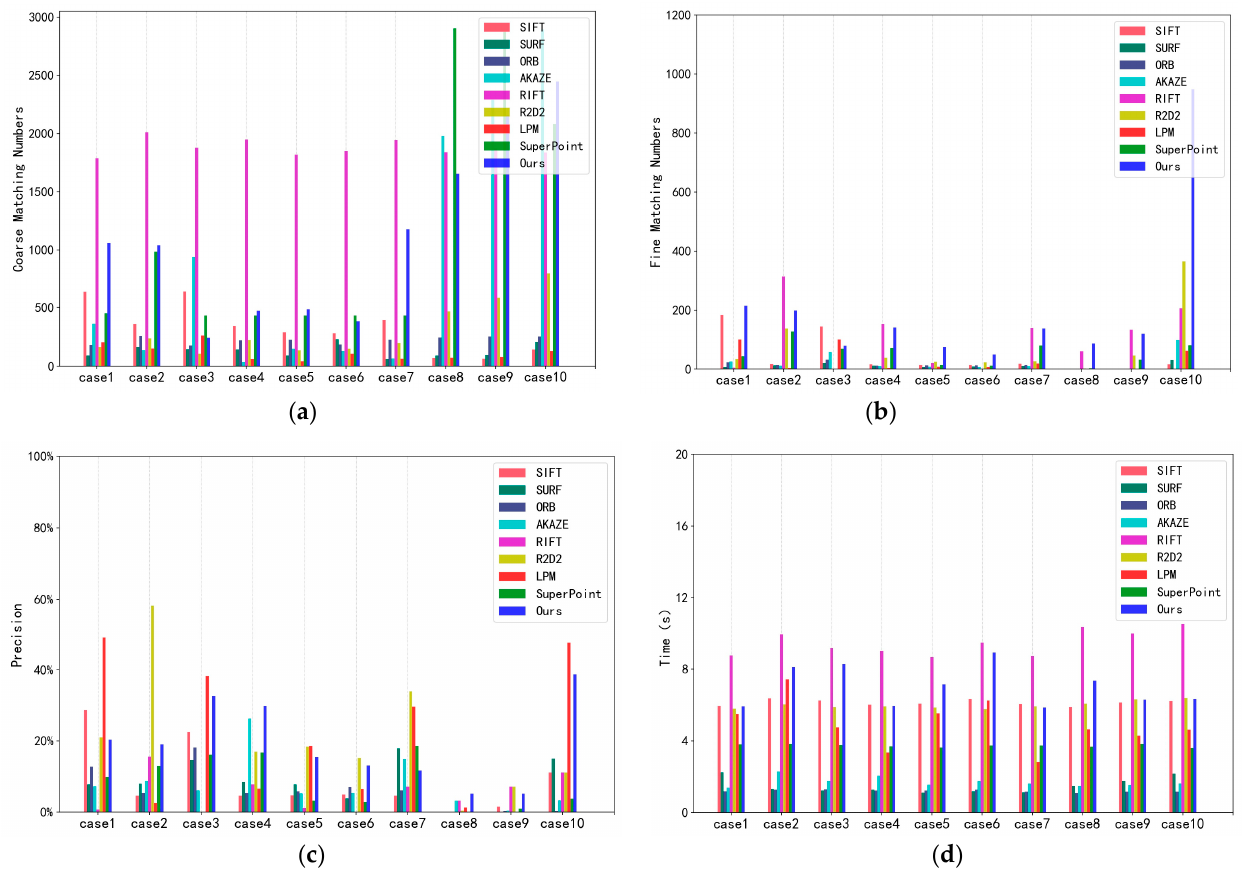
Figure 9. Multi-source image matching (the x-axis expresses different matching cases). ( a ) Coarse matching numbers; ( b ) Fine matching numbers; ( c ) Matching precision; ( d ) Matching time.